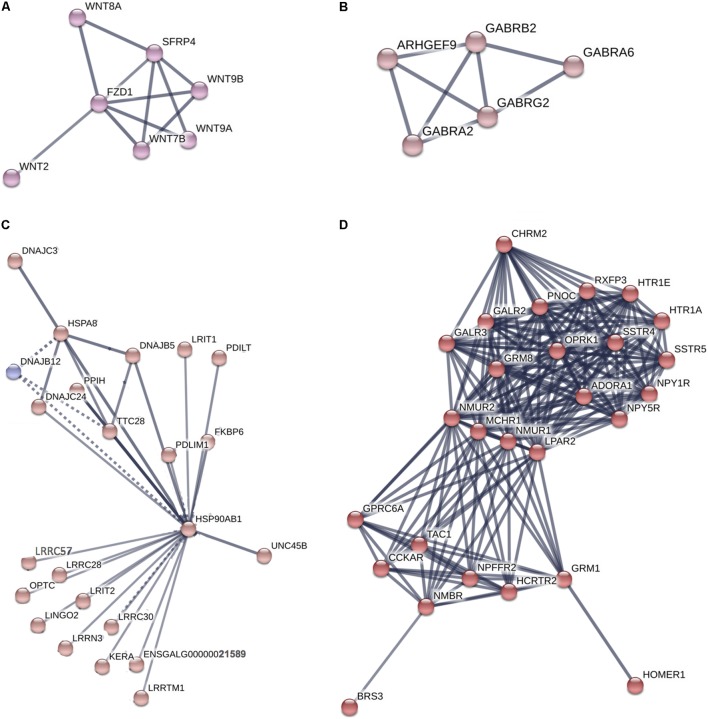
Network of genes highly expressed in the Harderian gland. Network generated by STRING. Edge thickness represents the confidence or strength of data support. A high confidence (0.700) cut-off was used to generate the network and all unconnected nodes were removed. Node color was based on MCL clustering (inflation parameter = 3). Supplementary Figure S1 includes the full network where a total of 836 nodes and 669 edges were included. The high number of nodes and edges led to a large network. From that network four clusters of interest (A–D) were chosen to display.